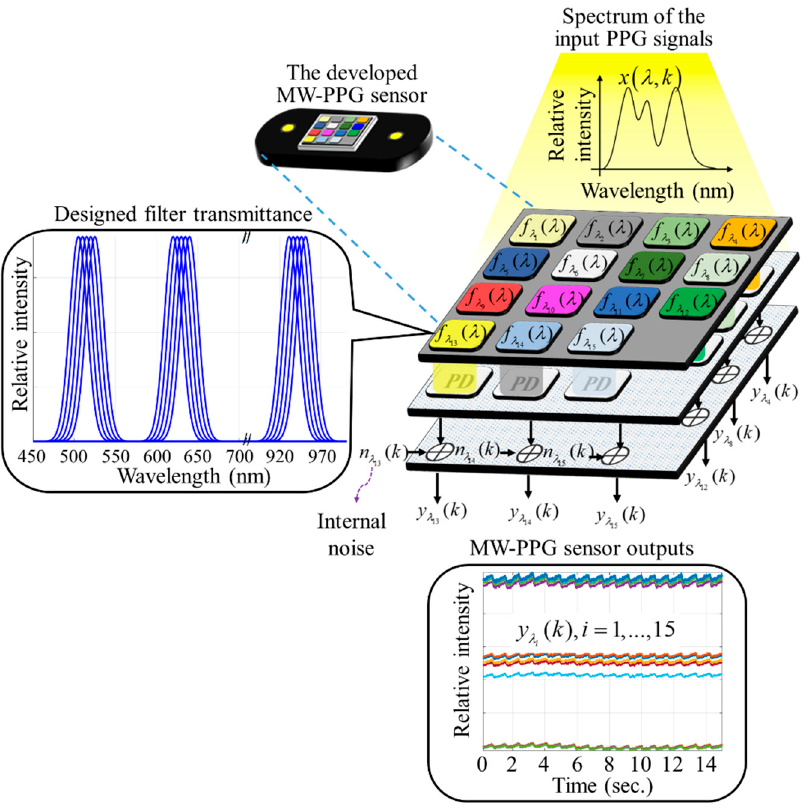
Figure 2. Schematic structure and mathematical model of the proposed MW-PPG sensor. 105